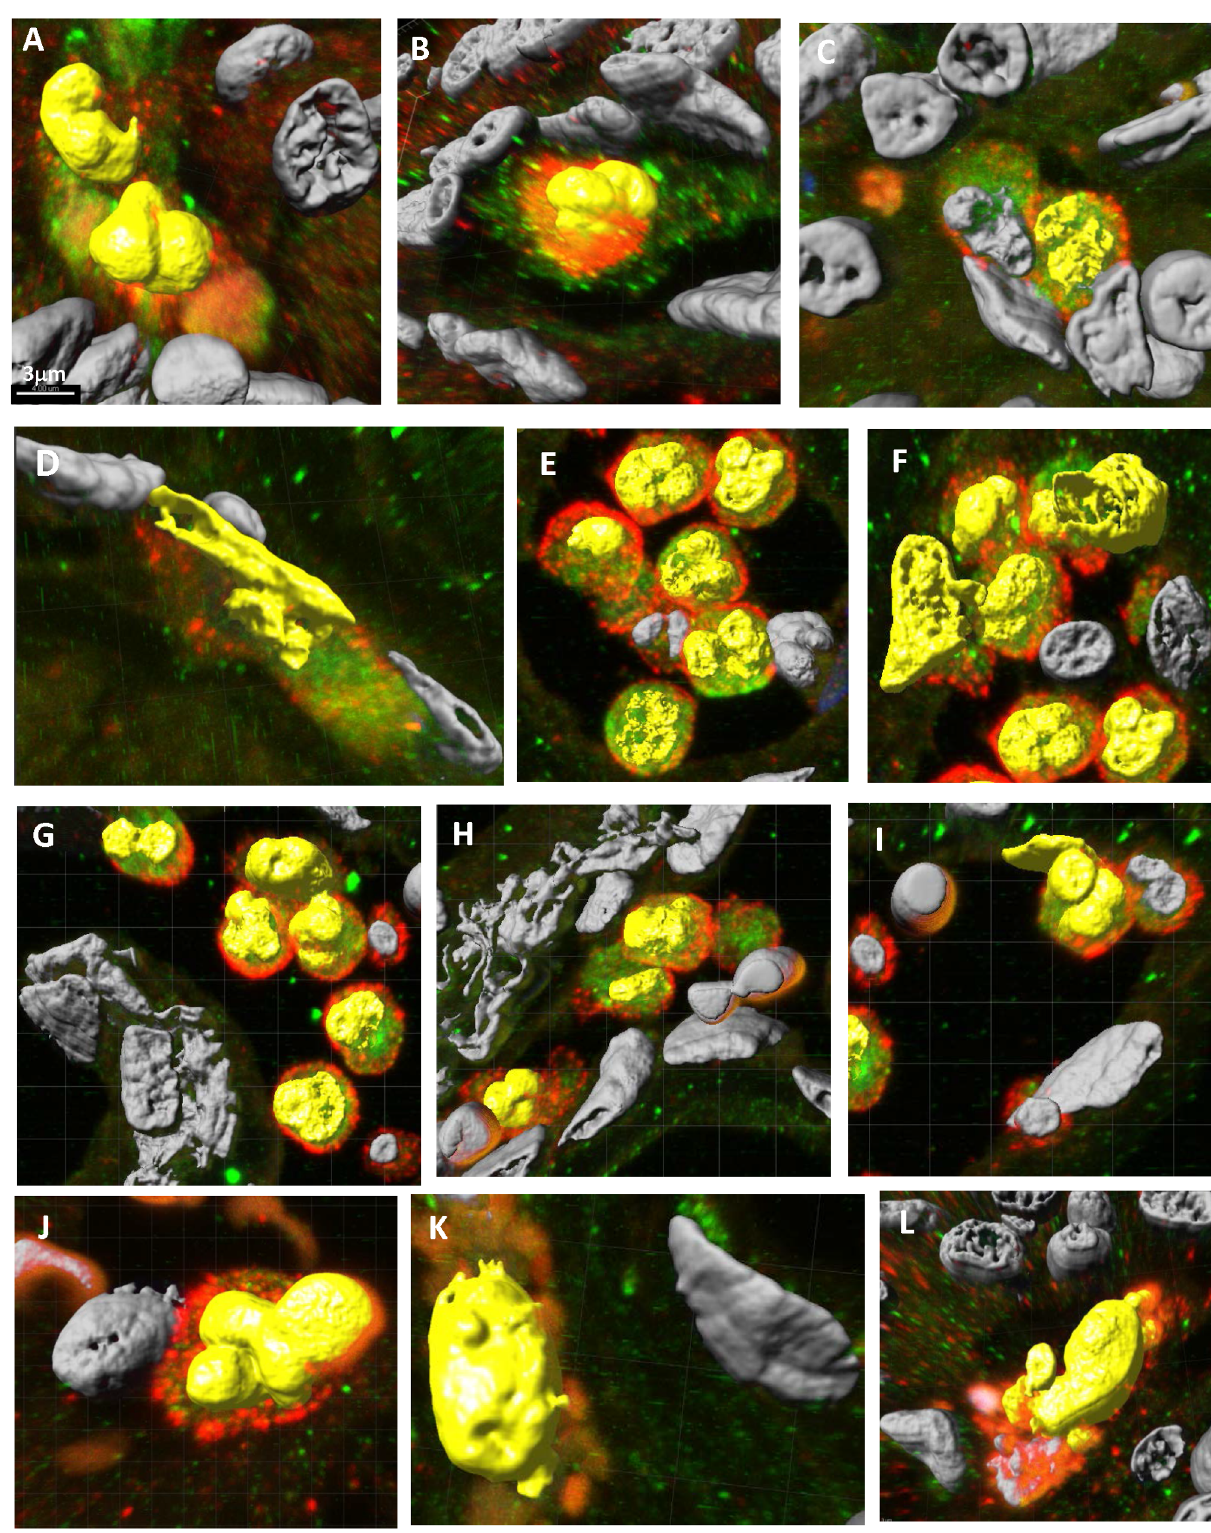
Fig 4. Representative 3D confocal images of MTFs in PDAC tissues from different patients which show various nuclear geometries (Yellow) of dual-stained cells. [ Panels A—I]: Dual stained for pancreatic tumor marker ZG16B (Red) and macrophage marker CD 206